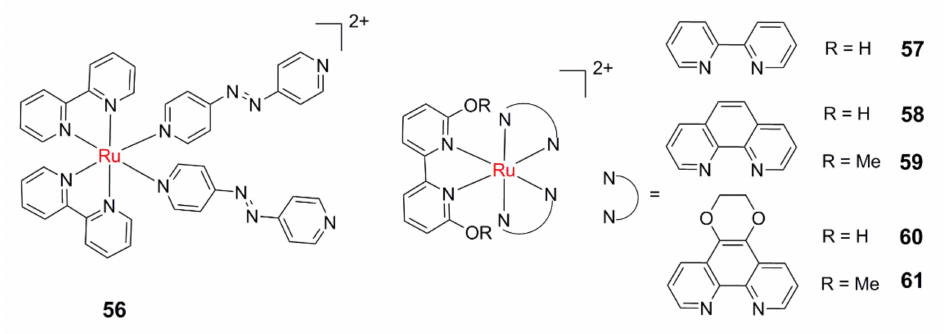
Figure 9. Dual-activatable Ru(II) PACT